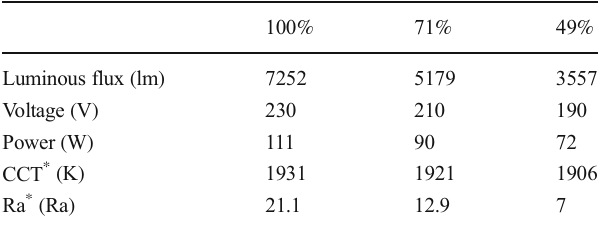
Characteristics and dimming information of the luminaires with different percentages of luminous